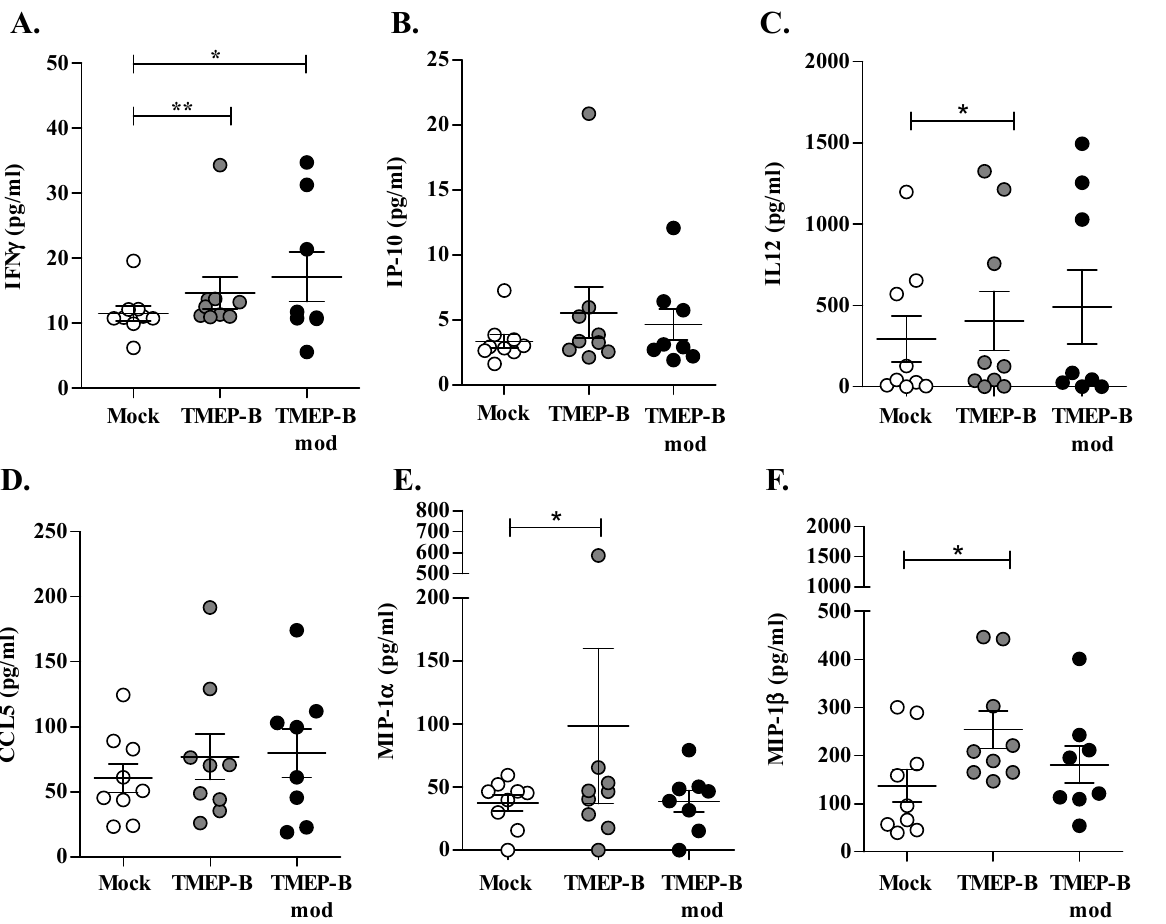
Figure 4. Cytokine secretion in the co-cultures of DC-T-cells in HIV infected patients. ( A – F ). Analysis of IFN γ , IP-10, IL12, CCL5, MIP-1 α , and MIP-1 β secretion after 6-days of co-cultures (DCs: T-cells), using DCs from HIV infected patients and electroporated with TMEP-B (gray circle) or TMEP-Bmod (black circle) ( n = 9). Mock transfected DCs were used as negative controls (white circle). Percentages ± SD are represented. Analysis was with the Wilcoxon signed rank test (* p < 0.05; ** p < 0.01; *** p < 0.001).